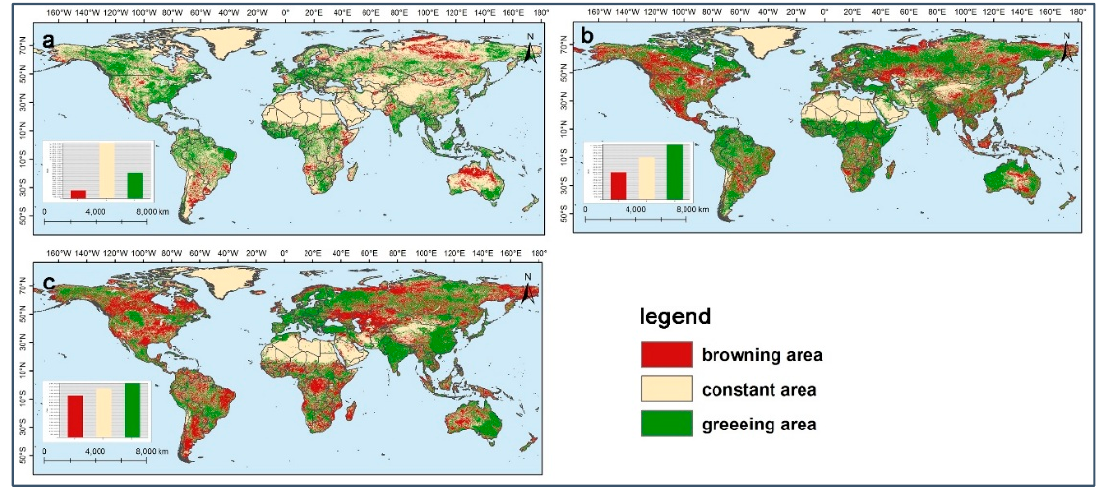
Figure 11. Trends in GIMMS NDVI 3g from 1982 to 1989 ( a ), 1990 to 1999 ( b ) and 2000 to 2015 ( c ).